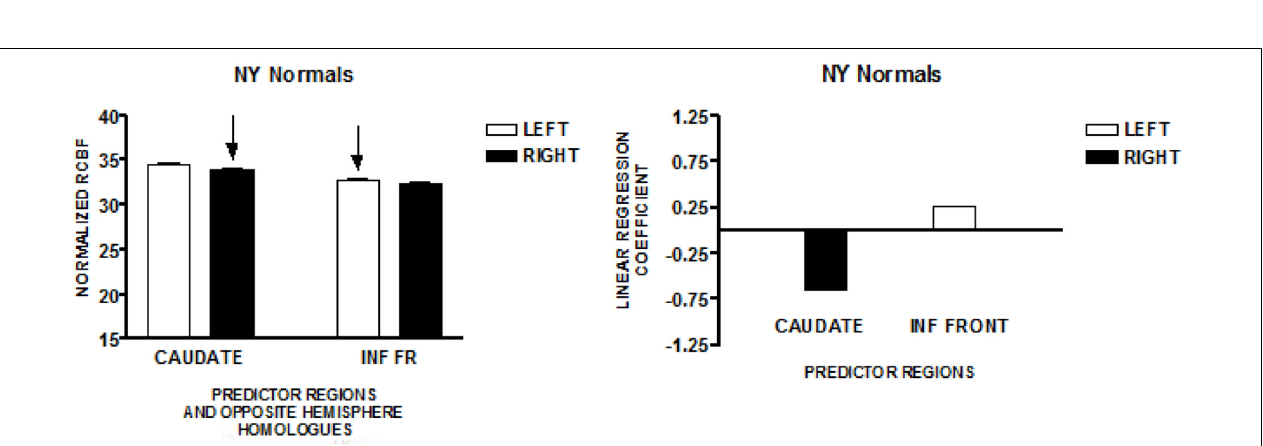
FIGURE 1 | The results from a study of speech production in a group of normal volunteers in Minnesota (MN). The graph on the left presents the mean normalized CBF ( ± SEM) for the head of the caudate nuclei, and the inferior frontal region, bilaterally. Neither homologous pair has a significant left–right difference. The regions that predict speech rate are indicated by arrows. The graph on the right presents the linear regression weights for the two regions that predict speech rate (Sidtis et al., 2003).